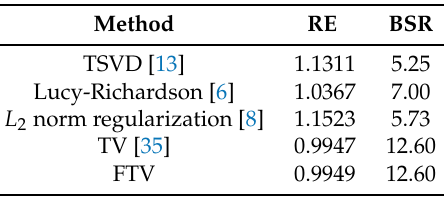
Table 4. The Comparison of RE and BSR.